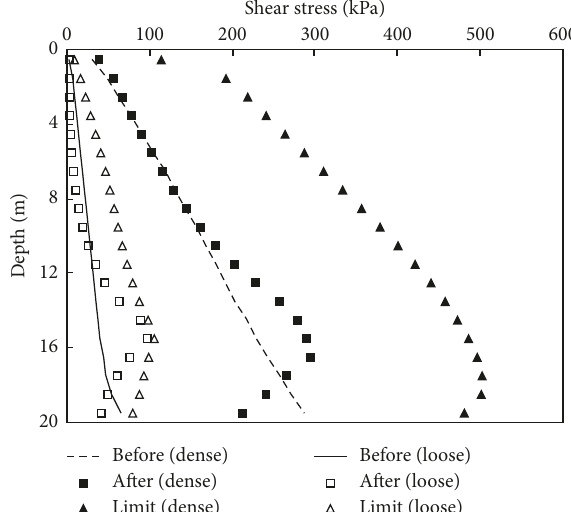
Figure 13: Distribution of the shear stress at the pile-soil interface for the free head pile.